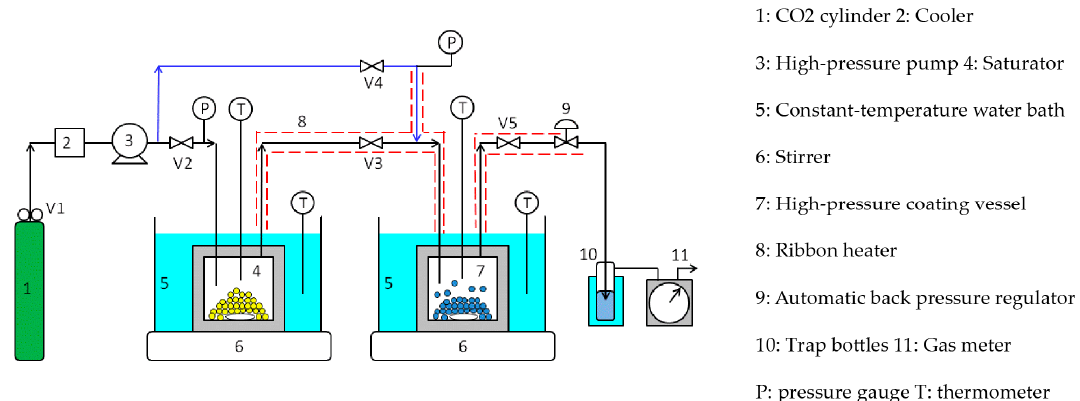
Figure 4. Semi-flow-type supercritical coating apparatus.